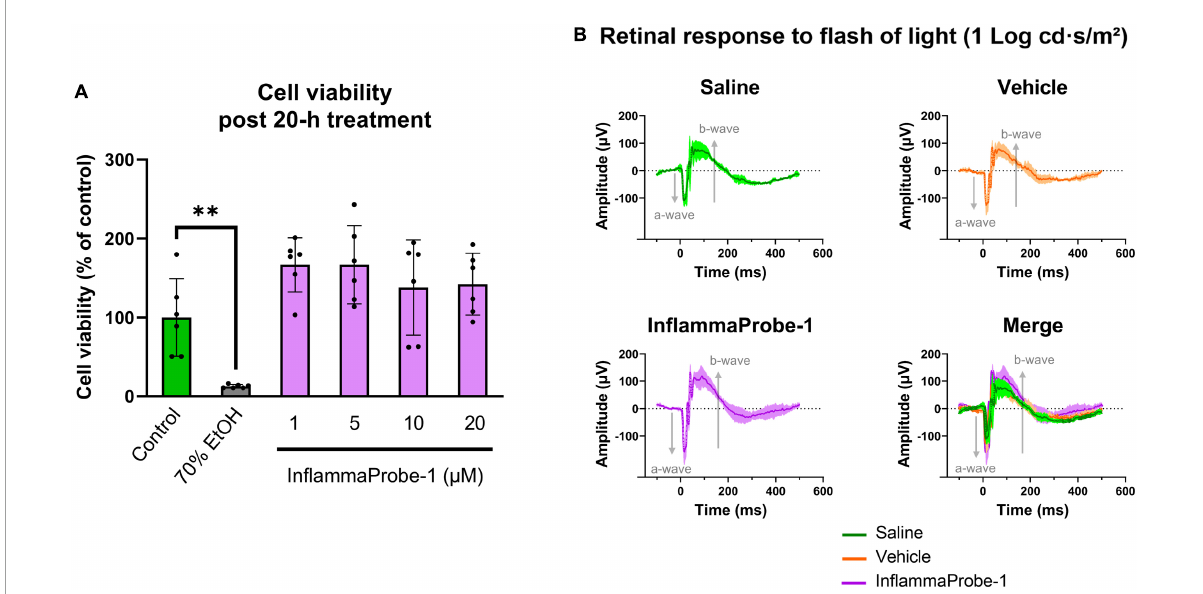
FIGURE6 Toxicity of InflammaProbe-1. (A) Cytotoxicity of InflammaProbe-1 was assessed in primary mouse retinal microvascular endothelial cells (MRMEC) using a fluorescence-based assay with Calcein Deep Red TM AM ester. The viability of MRMECs was not significantly reduced by a 20-h exposure to 1–20 µ M InflammaProbe-1 in comparison to untreated cells. (B) Retinal toxicity was assessed in dark-adapted mice using ganzfeld electroretinography (ERG) 7 days after an intraperitoneal injection of InflammaProbe-1 at 10 mg/kg. Relative to the retinas of mice injected with saline or a vehicle control (10% DMSO in PBS), the retinas of mice that had been injected with InflammaProbe-1 did not show any significant reduction in the a-wave and b-wave amplitudes of their electrical response to a 1 Log cd · s/m 2 light flash. These results suggest that InflammaProbe-1 is not toxic to primary cells or retinal tissues. Cell viability data were expressed as the mean ± SD of six replicates from each group. Statistical analysis by unpaired t -tests with Welch’s corrections; ∗∗ p < 0.01. ERG data were expressed as the mean ± SD of four retinas from each